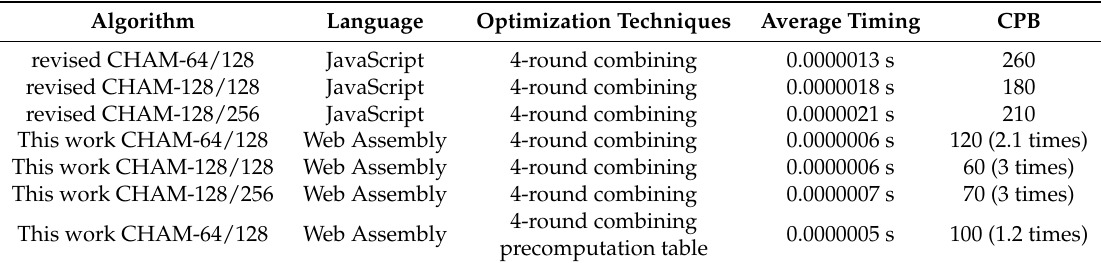
Table 10. Revised CHAM algorithm performance in Chrome (CPB : Cycle Per Byte).